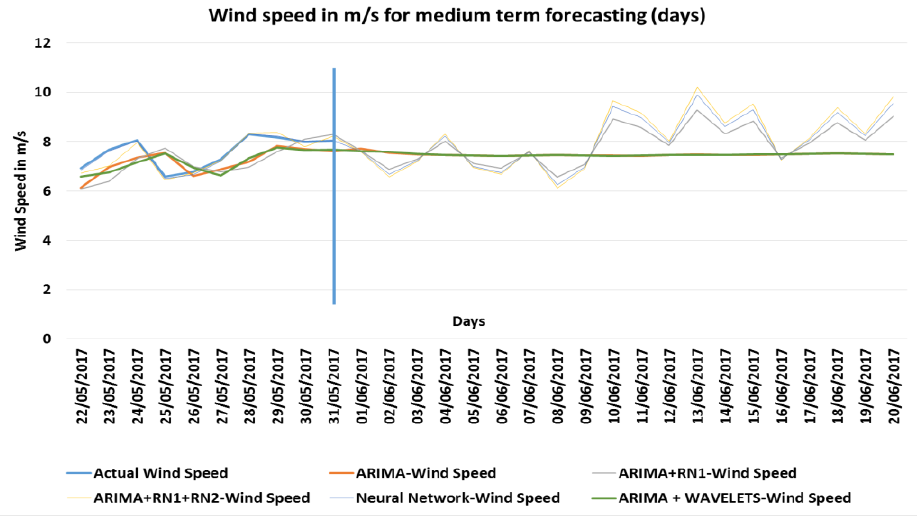
Figure 12. Speed values in m/s predicted for medium term in days.